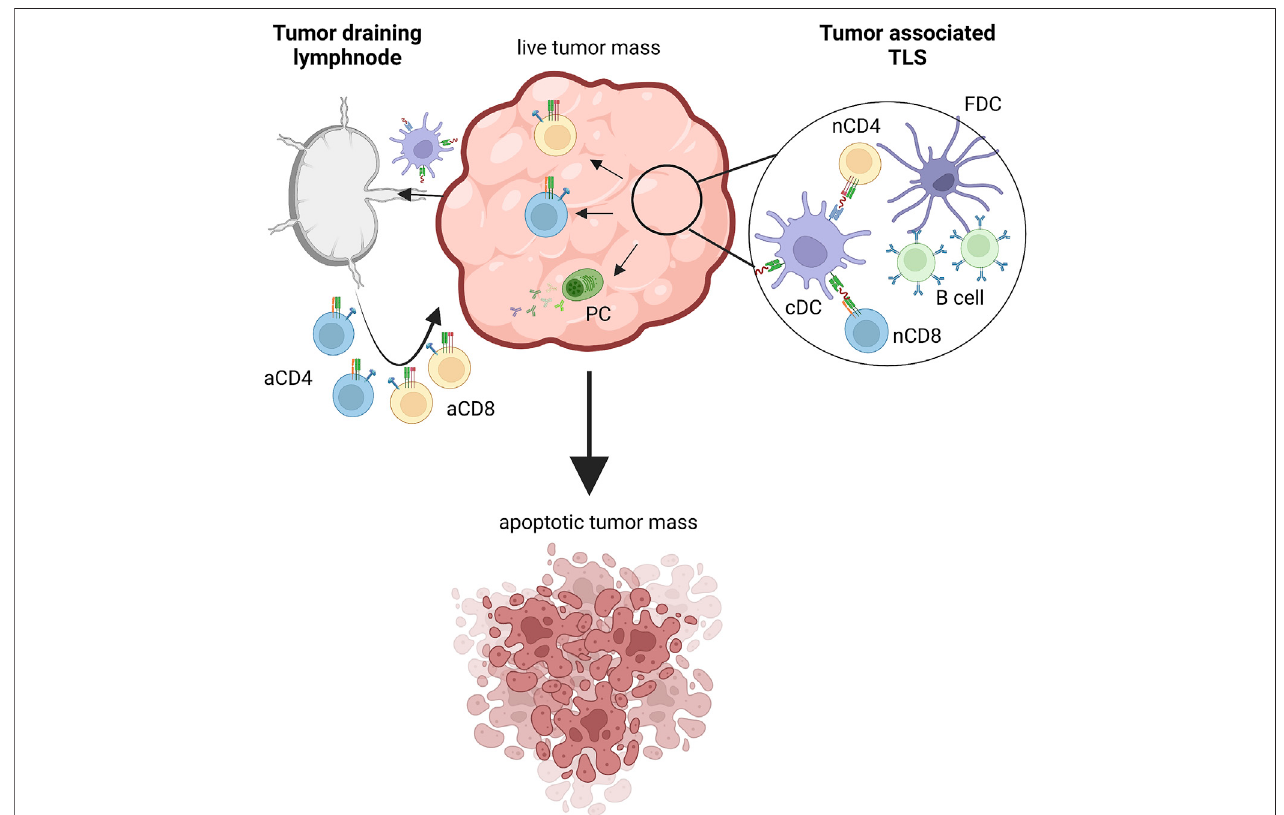
FIGURE 1 | Inductive sites of tumor-speci fi c immune responses. Tumor cells express tumor associated antigens (TAAs) sampled by dendritic cells that migrate to tumor draining lymph nodes where adaptive immune responses are triggered. Tumors also feature tertiary lymphoid structures (TLS) where tumor speci fi c T and B cells canbeprimed.Inbothcases,activatedtumor-speci fi cCD4 + andCD8 + Tcellsmigrate withinthetumormassandattacktransformedcells,ultimatelyinducingapoptotic cell death. Also plasma cells participate in antitumor immunity by producing tumor speci fi c antibodies. aCD4, activated CD4 T cell; aCD8, activated CD8 T cell; nCD4, naive CD4 T cell; nCD8, naive CD8 T cell; PC, plasmacell; cDC, conventional dendritic cell; FDC, follicular dendritic cell. Created with BioRender.com.